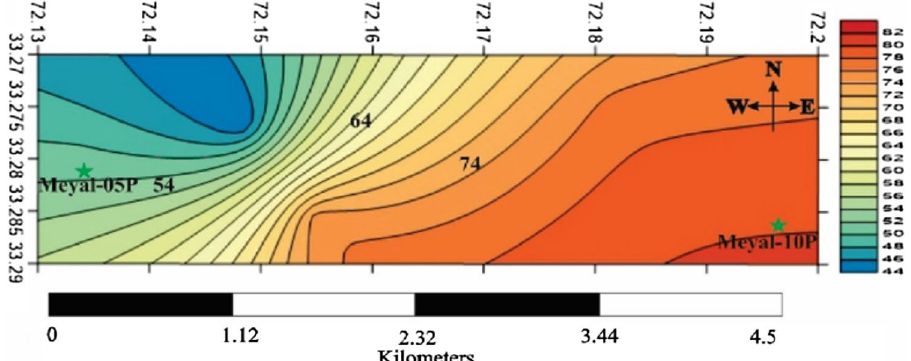
Fig. 6 Isopach map of the Lockhart Limestone showing its thicknesses in Meyal-05P and Meyal-10P